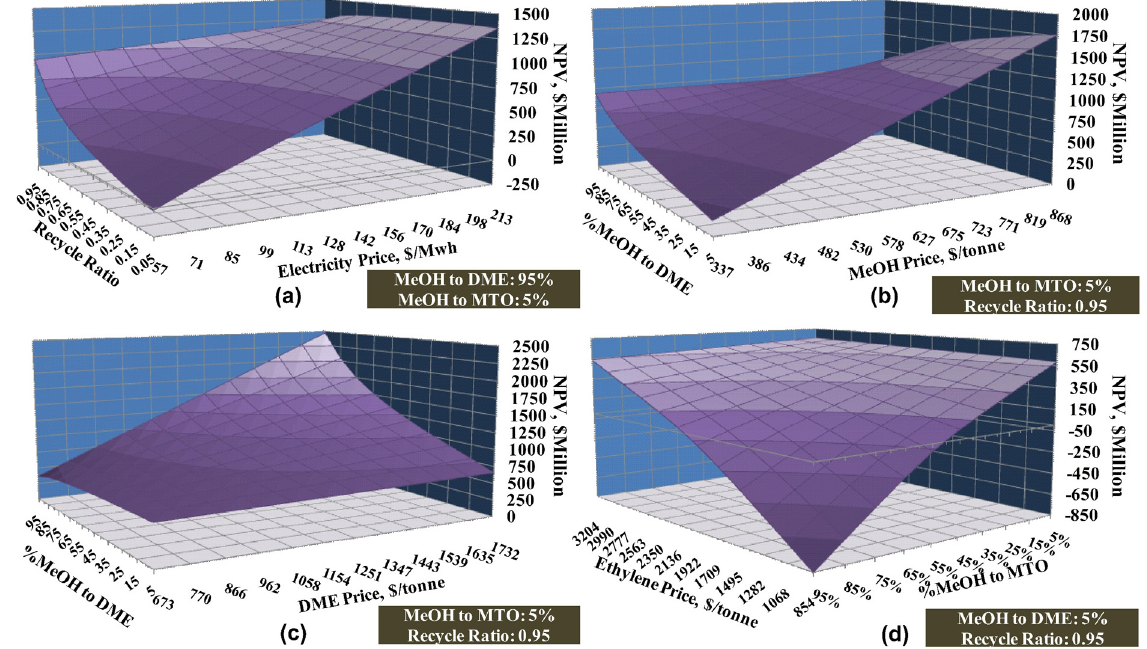
Figure 2. The NPV of plant at different market prices and selected decision variables changes: ( a ) recycle ratio and Electricity price; ( b ) %MeOH to DME and MeOH price; ( c ) %MeOH to DME and DME price; ( d ) %MeOH to MTO and ethylene